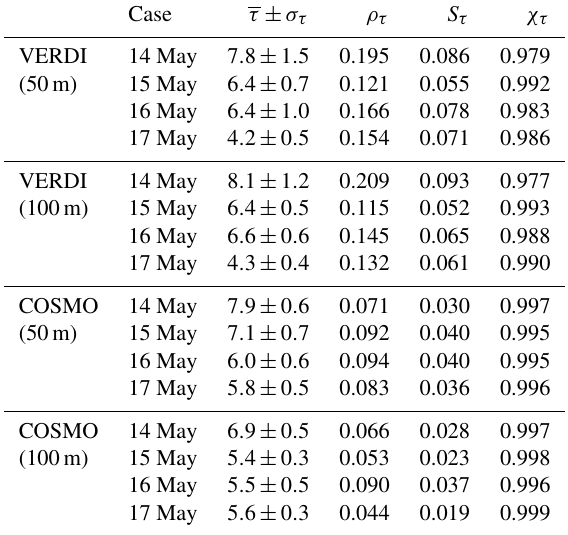
Table 2. Mean value of τ , standard deviation σ τ , and the three 1-D inhomogeneity parameters ( ρ τ , S τ , and χ τ ) calculated for all four cases from the observations and the simulations with the two differ- ent spatial resolutions of 50 and